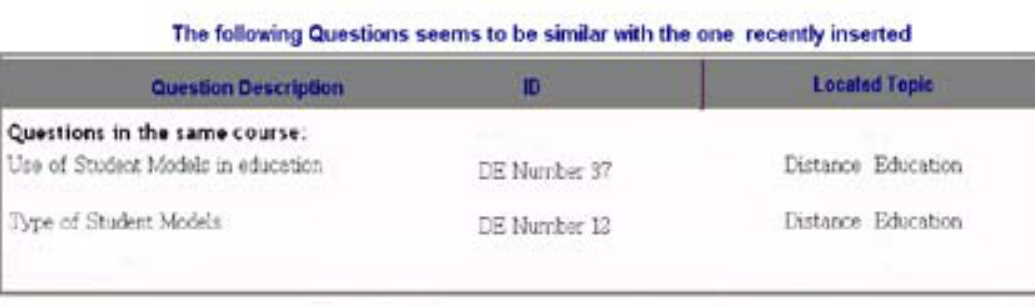
Figure 3. Potential similar